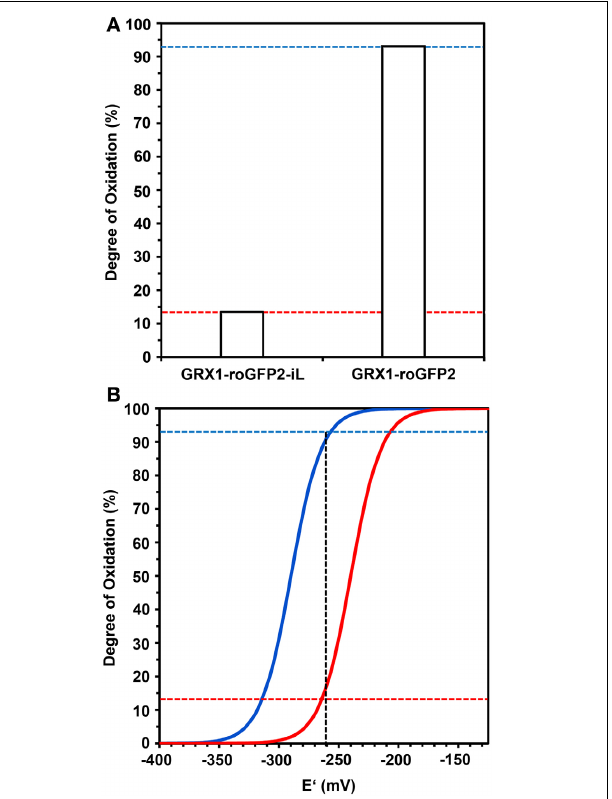
FIGURE 9 | Deduction of the redox potential of the roGFP probes from the Degree of Oxidation ( OxD ) in the cytosol of rml1 seedlings. (A) GRX1-roGFP2-iL and GRX1-roGFP2 expressed in the cytosol of rml1 plants as calculated according to equations given in Materials and Methods from the mean fluorescence data presented in Figure 7 . While GRX1-roGFP2 is highly oxidized only a small fraction of GRX1-roGFP2-iL is in the oxidized state. (B) Titration curves drawn for GRX1-roGFP2 (blue) and GRX1-roGFP2-iL (red) were calculated from the Nernst-Equation using the midpoint potentials determined in Figures 3 , 4 . Dotted horizontal lines refer to OxD of GRX1-roGFP2 and GRX1-roGFP2-iL from rml1 measurements shown in panel (A) . The vertical dotted line indicates the interception points for GRX1-roGFP2 (blue) and GRX-roGFP2-iL (red) which suggests an E GSH of about − 260mV in the cytosol of rml1